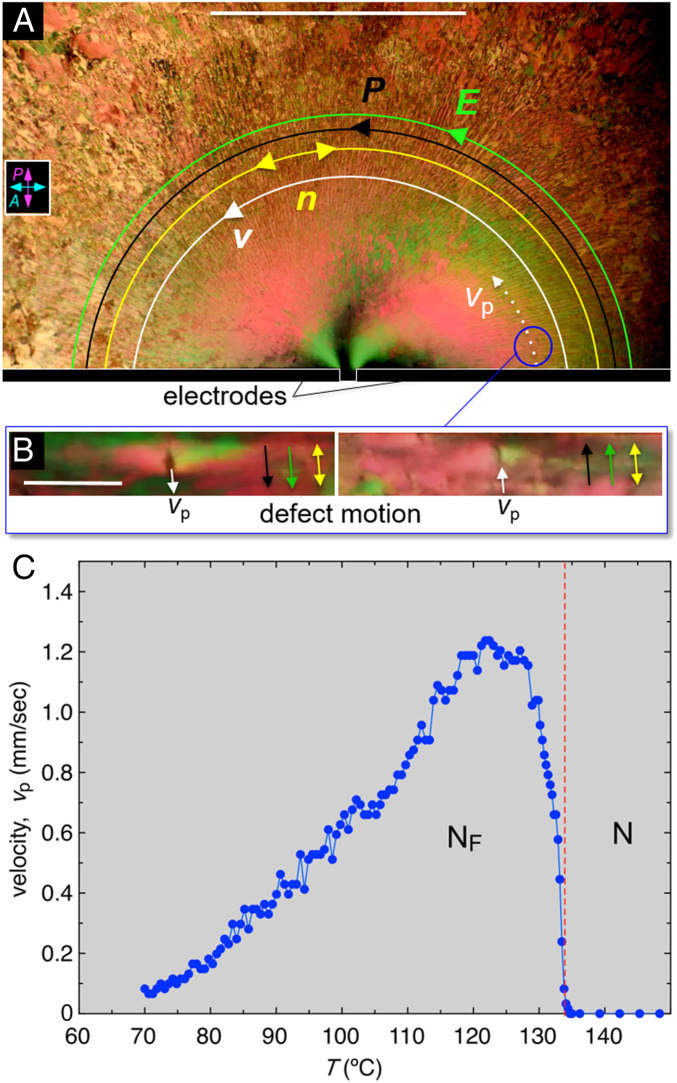
Field-induced flow in the ferroelectric nematic phase. (A) DTLM image of a t = 10-µm-thick, planar-aligned cell of RM734 between untreated glass plates, in the NF phase at T = 120 °C. The black bars at the bottom are two evaporated gold electrodes on one of the plates, separated by a d = 60 µm gap. The electrodes are outlined in white for clarity. Only the upper edges of the electrodes and the adjacent part of the cell are shown. A square-wave voltage with Vp = 3 V, 0.1 Hz, is applied to the electrodes, producing an electric field in the plane of the cell. This field drives a pattern of defect motion and fluid flow over the entire field of view, with the defect velocity v(r) (white arrows) parallel to the applied field, E(r) (green), which is tangent to half-circles centered on the electrode gap (SI Appendix, Fig. S12). Where the defects are dense, their motion transports the surrounding fluid. When the field is applied, the entire region shown here moves along the field lines. This image, captured during field reversal, shows a periodic array of bend domain walls normal to the director (yellow) and the applied field, as in Fig. 5A, in this case along radial lines. (B) Typical defect in the texture moving along the applied field direction (down in Left and up in Right), in the location circled in A. (C) Temperature dependence of the magnitude of the initial defect velocity along the white dashed track in A following a field reversal. There is no flow in the N phase but on cooling into the NF phase, the velocity increases rapidly with increasing P before decreasing again at lower T because of the increasing viscosity. A similar dependence on T is observed whether heating or cooling. (Scale bars, 1 mm in A and 100 µm in B.)